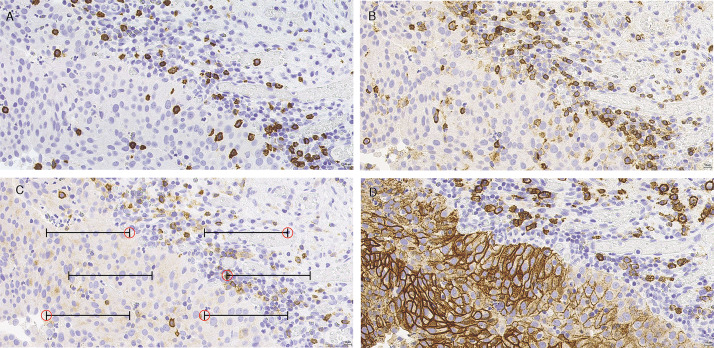
Immune cell markers CD8, CD4, CD25 and CD138 in representative urothelial bladder cancer tissue.(A) CD8 IHC stain (400X magnifications), (B) CD4 IHC stain (400X magnifications), (C) CD25 IHC stain (400X magnifications) (D) CD138 IHC stain (400X magnifications). In each field of vision positively stained immune cells were quantified as “positive counts” and negatively stained immune cells and other cell types were quantified as “negative counts”. Counts were registered using six electronic grids with five endpoints. Scale bar 10 μm.